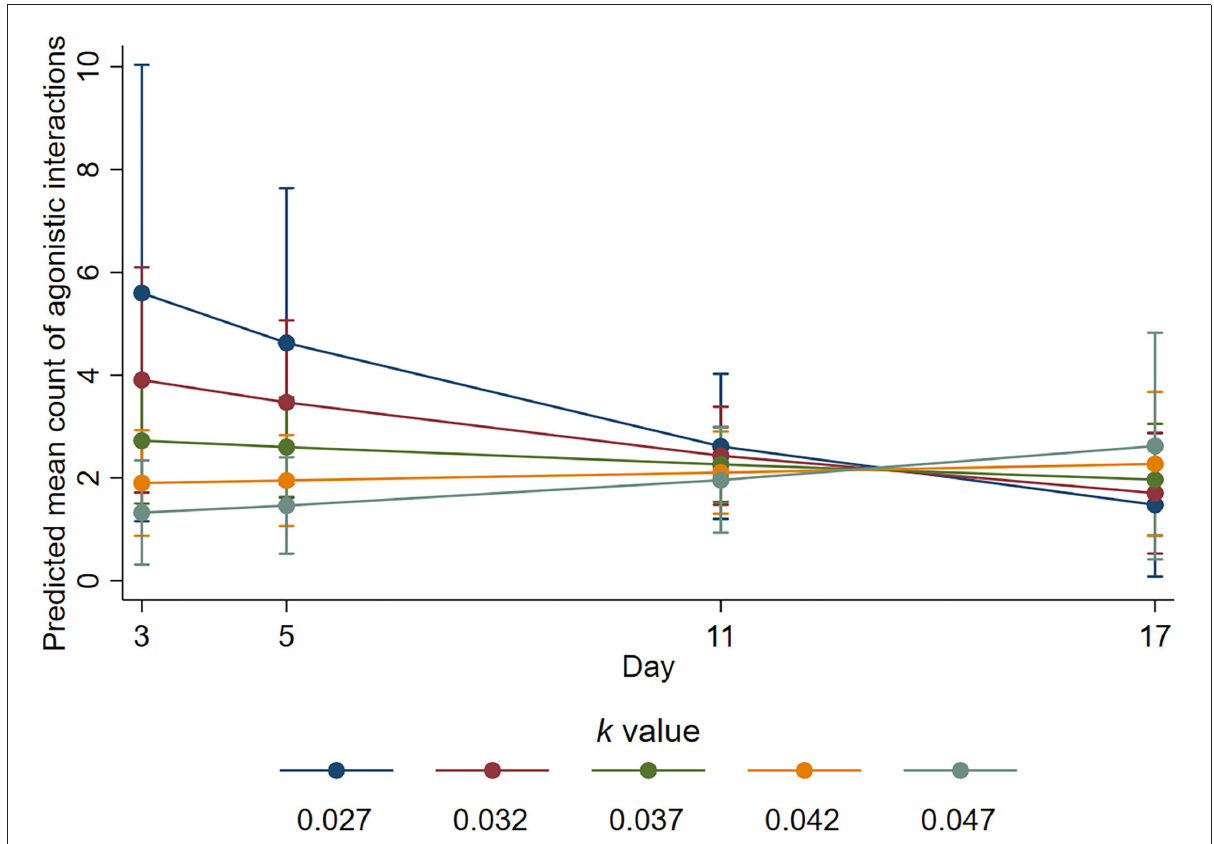
FIGURE4 Predicted mean counts of agonistic interactions during the active observation for all k -value treatments on each observation day. Error bars represent 95% confidence intervals of predicted mean